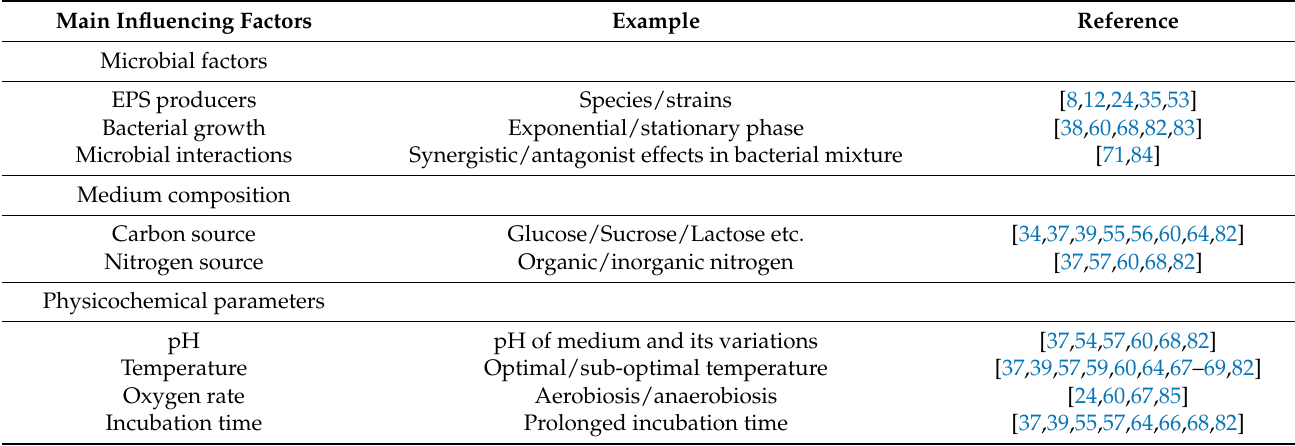
Table 3. Main factors influencing EPS production by LAB